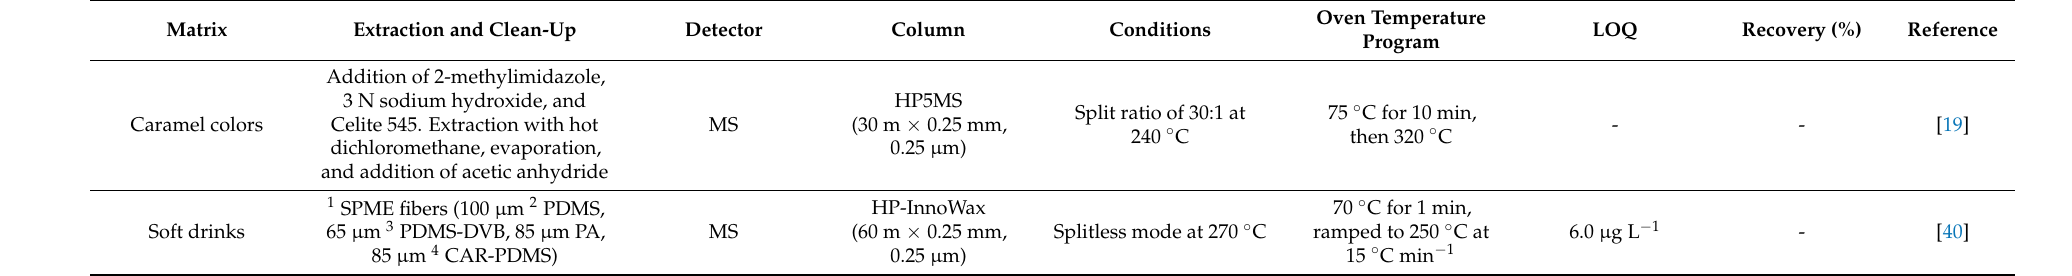
Table 3. Gas chromatography methods extraction and analysis of 4(5)-methylimidazole in food